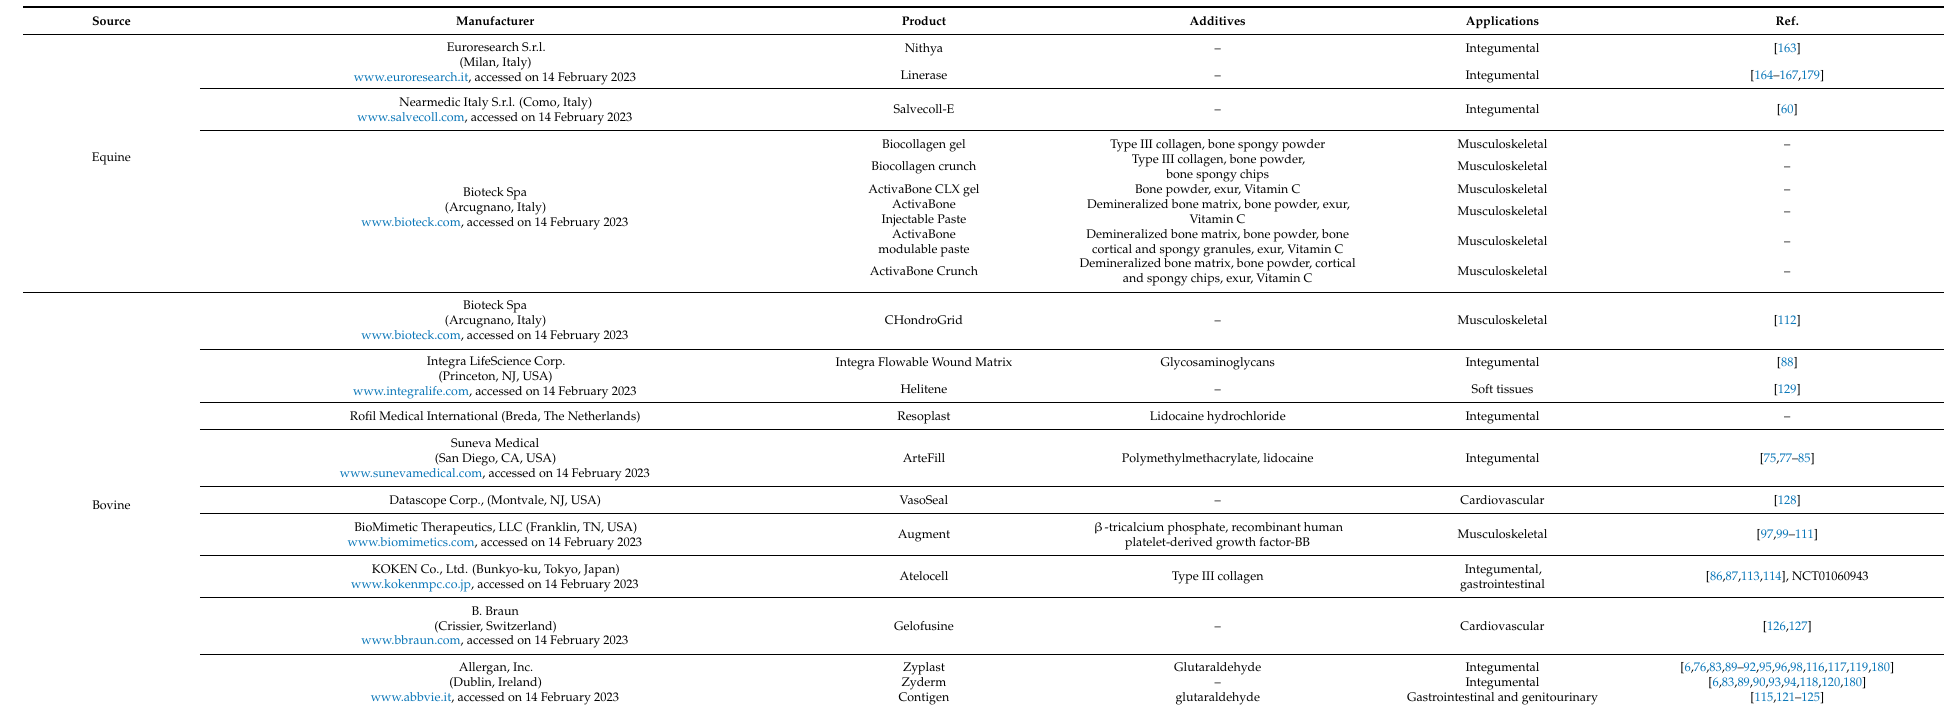
Table 2. Summary of clinically available type I collagen-based injectable